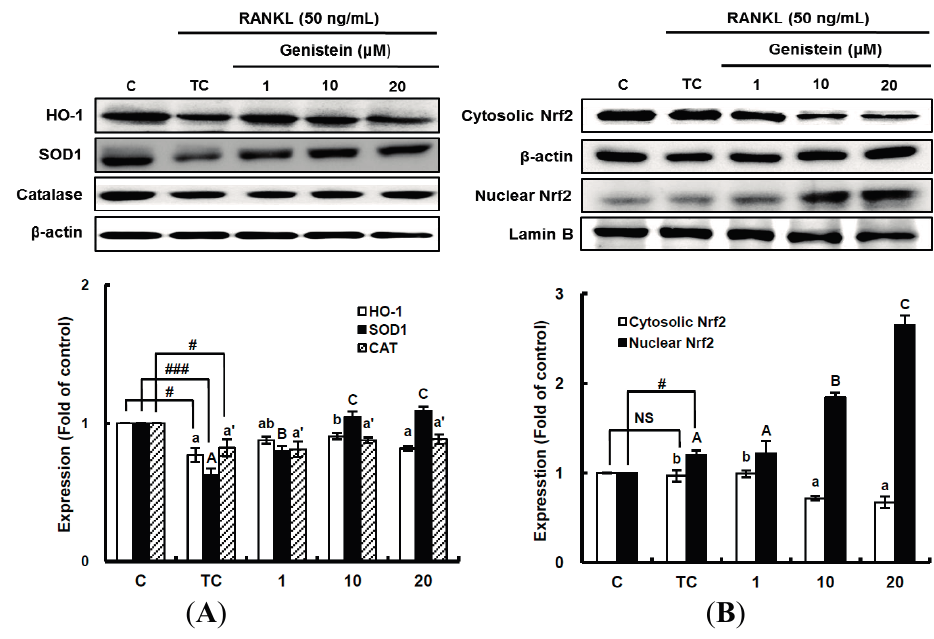
Figure 6. The effects of genistein on the expression of detoxifying and antioxidant enzymes ( A ) and the activation of Nrf2 ( B ) in RANKL-treated RAW 264.7 cells. RAW 264.7 cells were exposed to the receptor activator of nuclear factor kappa-B ligand (RANKL) (50 ng/mL) for two days in the absence and presence of genistein. RAW 264.7 cells were lysed in radioimmunoprecipitation assay (RIPA) buffer (50 mM Tris-HCl (pH 8.0), 1% nonyl phenoxypolyethoxylethanol (NP)-40, 0.5% sodium deoxycholate, 150 mM NaCl and 1 mM phenylmethylsulfonyl fluoride (PMSF)) that contained a phosphatase inhibitor cocktail. The nuclear proteins in the RAW 264.7 cells were extracted by using Buffer A (10 mM hydroxyethyl piperazineethanesulfonic acid (HEPES), pH 7.9), 10 mM KCl, 2 mM MgCl , 1 mM dithiothreitol (DTT), 0.5 mM ethylenediamine 2 tetra-acetic acid (EDTA) (pH 7.9), 0.1 μ M PMSF and 1× protease inhibitor cocktail) and Buffer B (50 mM HEPES (pH 7.9), 50 mM KCl, 0.3 mM NaCl, 1 mm DTT, 1 mM EDTA (pH 7.9), 0.1 μ M PMSF and 10% glycerol). Western blotting analysis was performed on the lysates of cells that had been incubated with 1–20 μ m genistein. Different corresponding letters indicate significant differences at p < 0.05 by Duncan’s